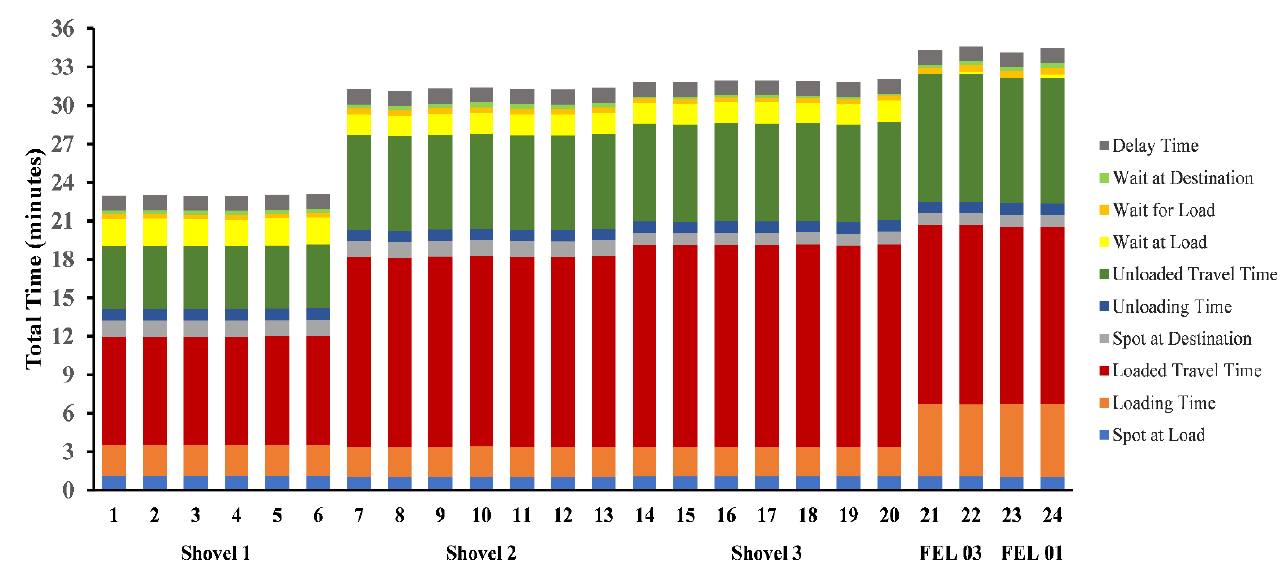
Figure 4. Truck cycle time for each loading equipment.